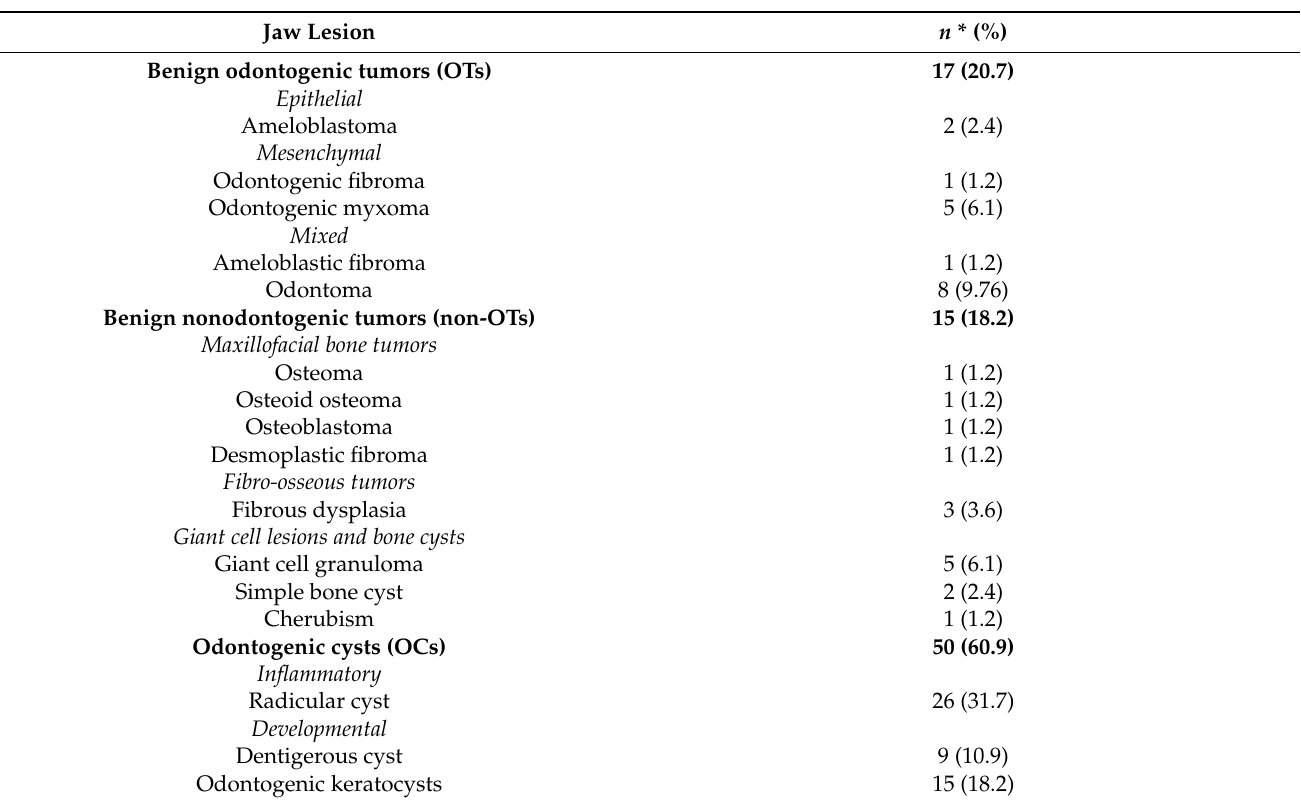
Table 2. Distribution and prevalence of pediatric jaw lesions according to the 5th WHO